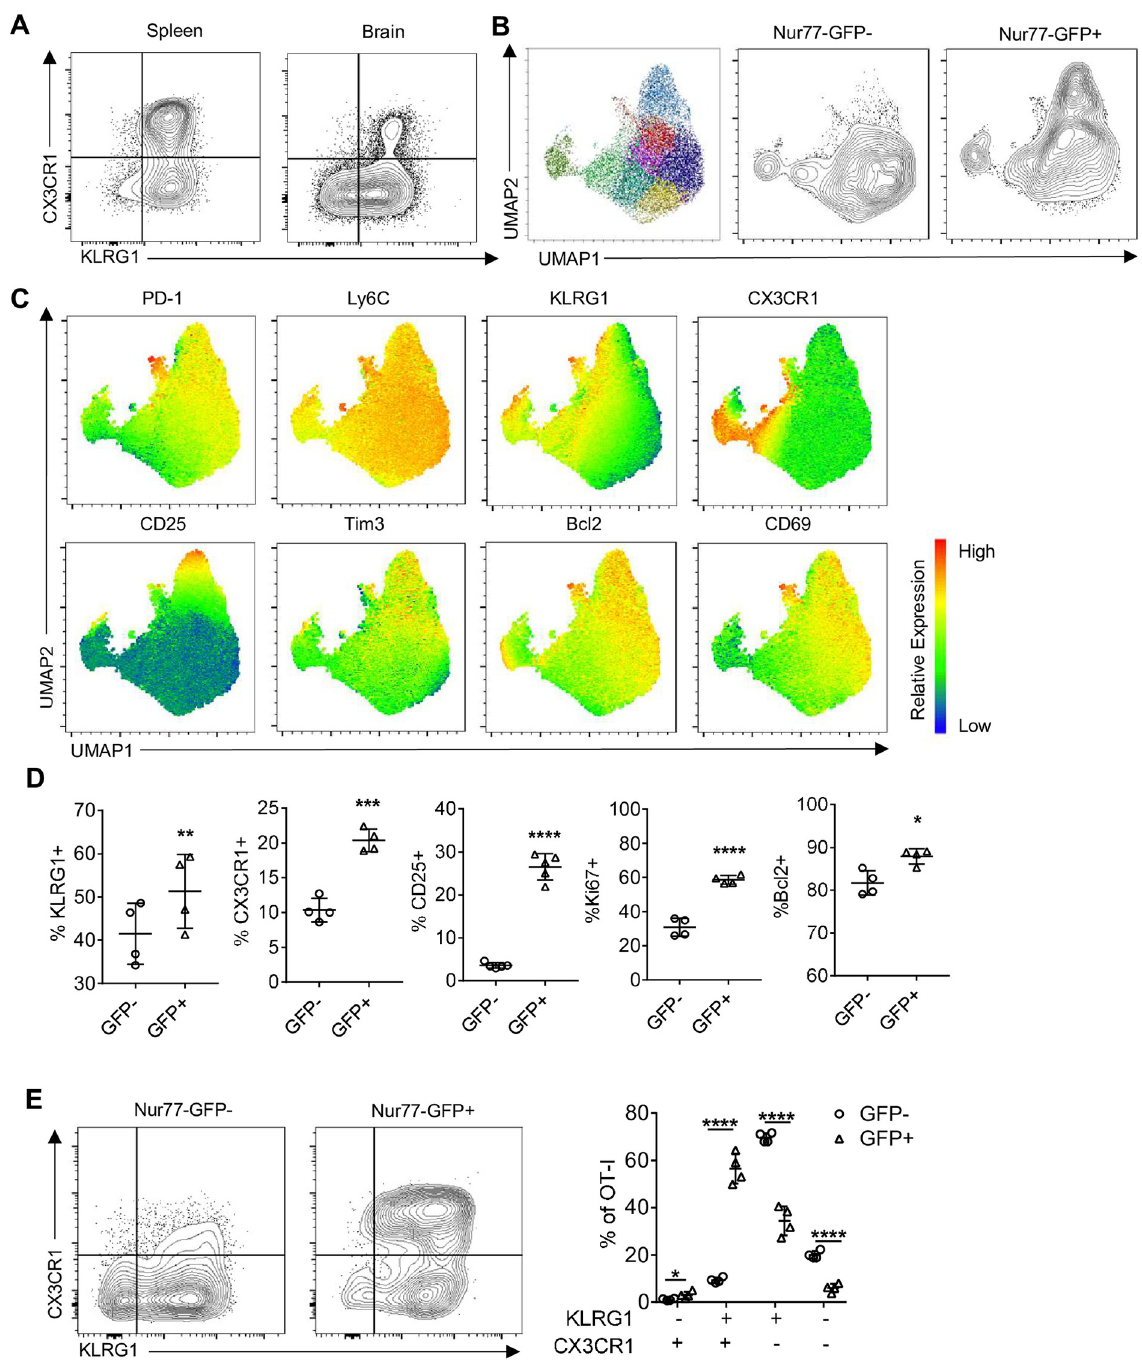
Fig 6. Infection induced phenotype of CNS T . gondii specific CD8 + T cells during early infection. (A) Phenotype of OT-I in spleen (left) and brain (right) of T . gondii -OVA infected mice 14 dpi (representative of N = 4 mice per tissue). (B-E) High dimensional flow cytometry with UMAP and Phenograph clustering was performed on brain OT-I at 14 dpi (N = 4 mice). (B) UMAP segregation of clusters of all OT-I (left), Nur77-GFP + OT-I (center), and Nur77-GFP + OT-I (right). (C) Heatmap of marker expression from UMAP. (D-E) Frequency of marker positive OT-I within Nur77-GFP - or Nur77-GFP + OT-I fraction. P values based on Paired T-test � p < 0.05 �� p < 0.01 ��� p < 0.001 ���� p < 0.0001; error bars indicate SD.